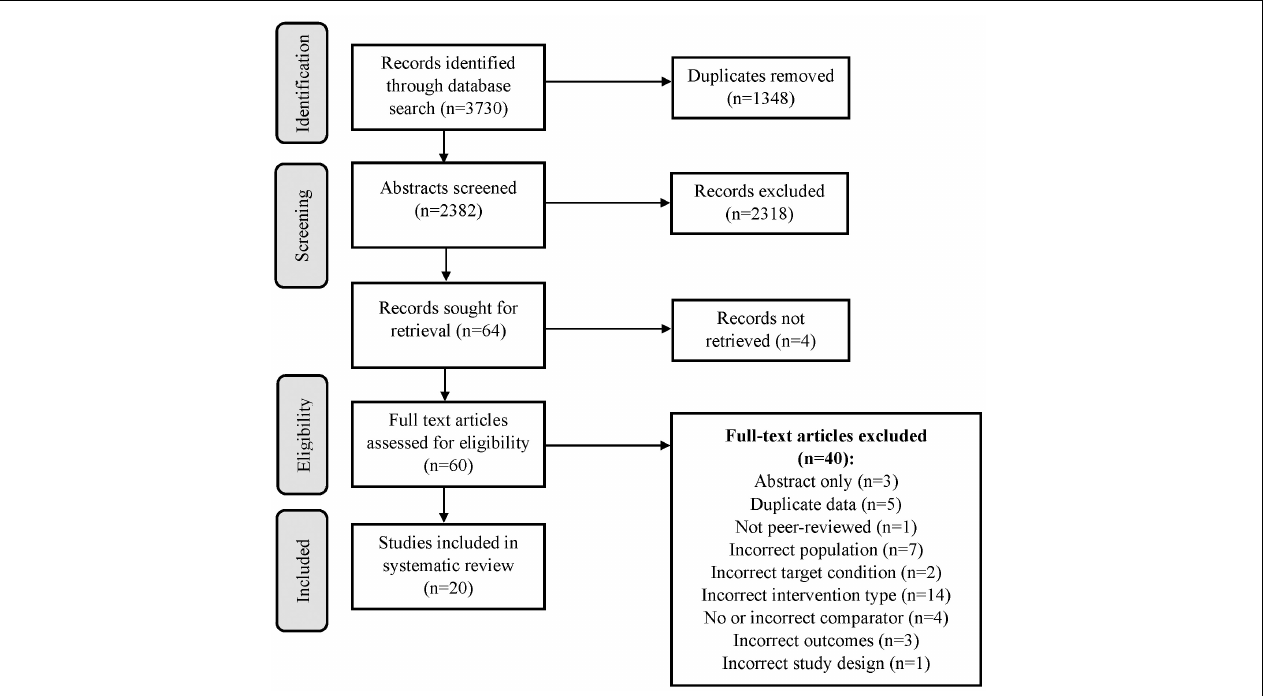
FIGURE 1 | PRISMA flow